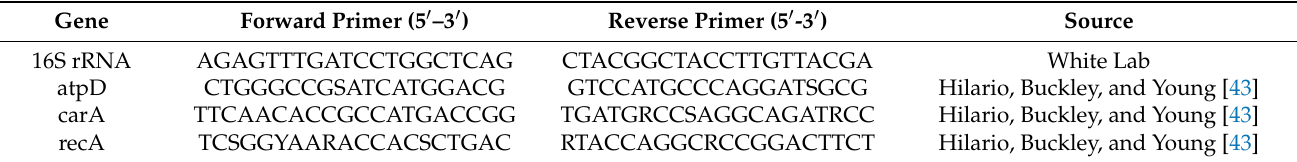
Table 1. Primers used in the identification of A. palmeri seed endophytes.